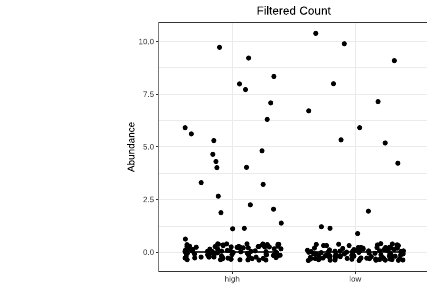
Figure 4. Bacterial species that were significantly more abundant in the group with high VEGETABLES intake (FDR < 0.05) by metagenomeSeq test. Red boxes represent participants with a higher adherence to the MD and blue boxes low adherence.